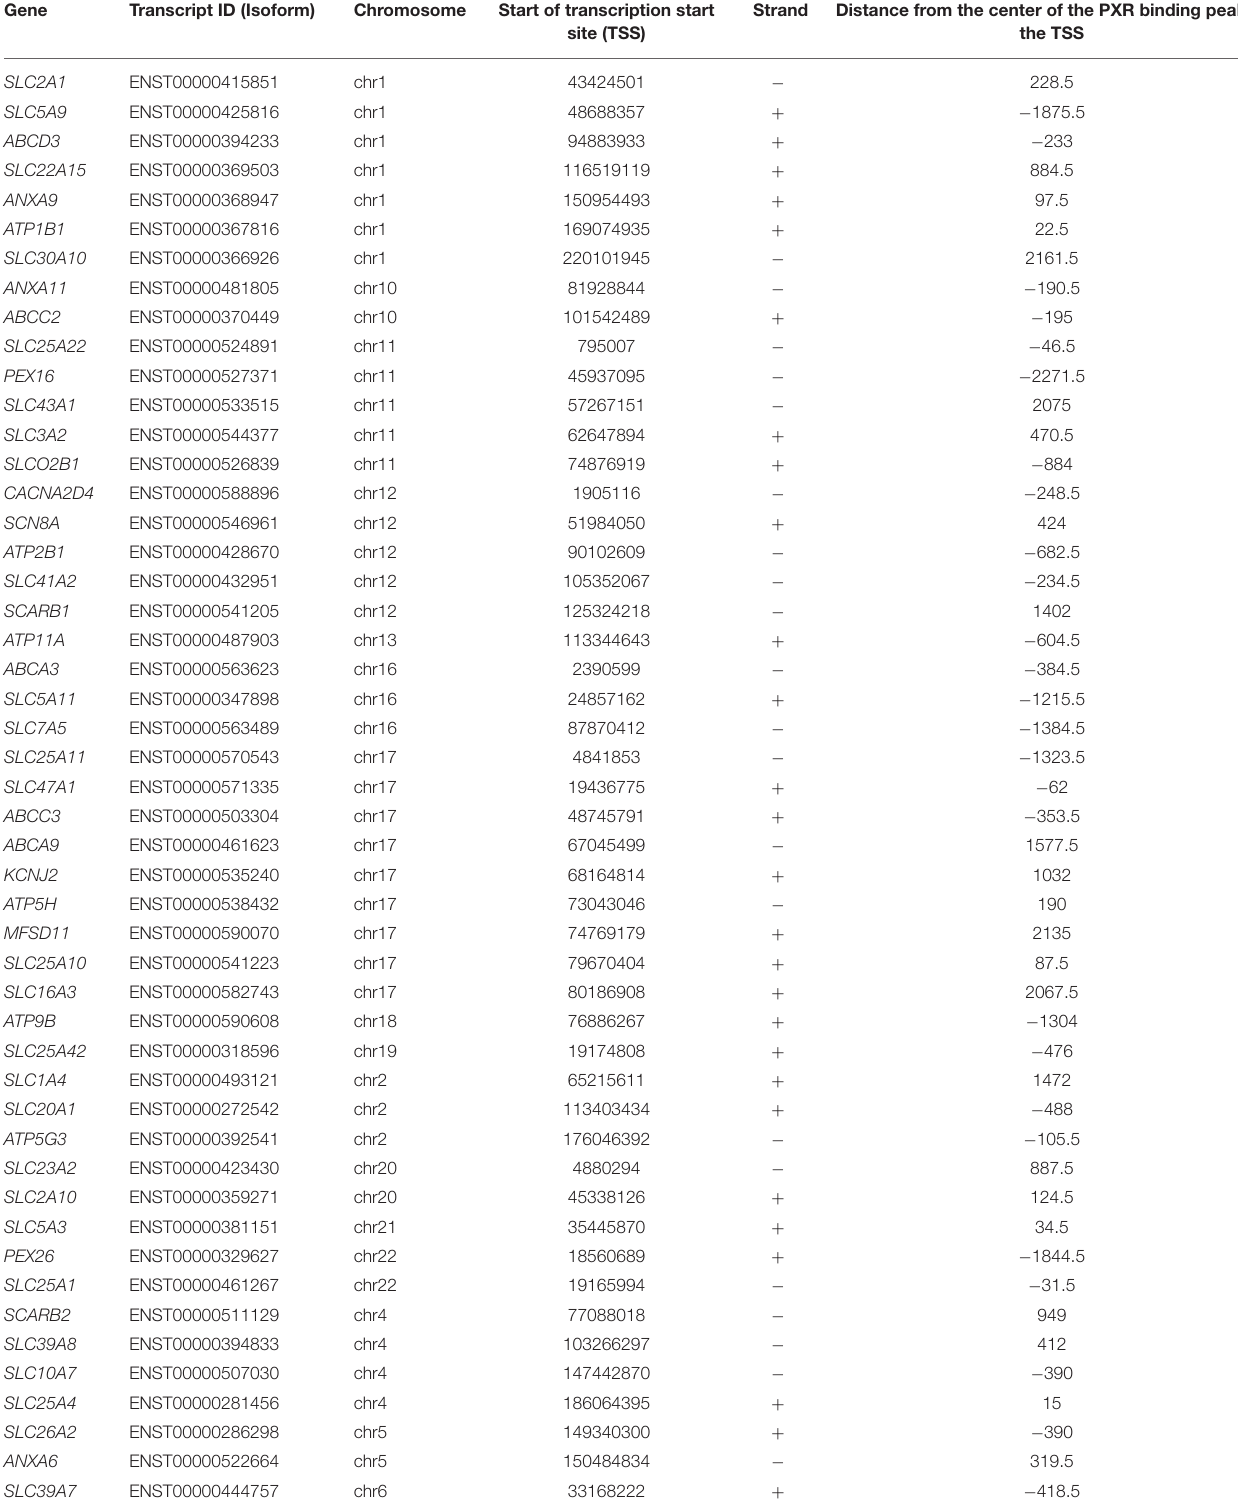
TABLE 4 | The 58 transporters with ChIP-Seq determined PXR binding sites. Gene Transcript ID (Isoform) Chromosome Start of transcription start